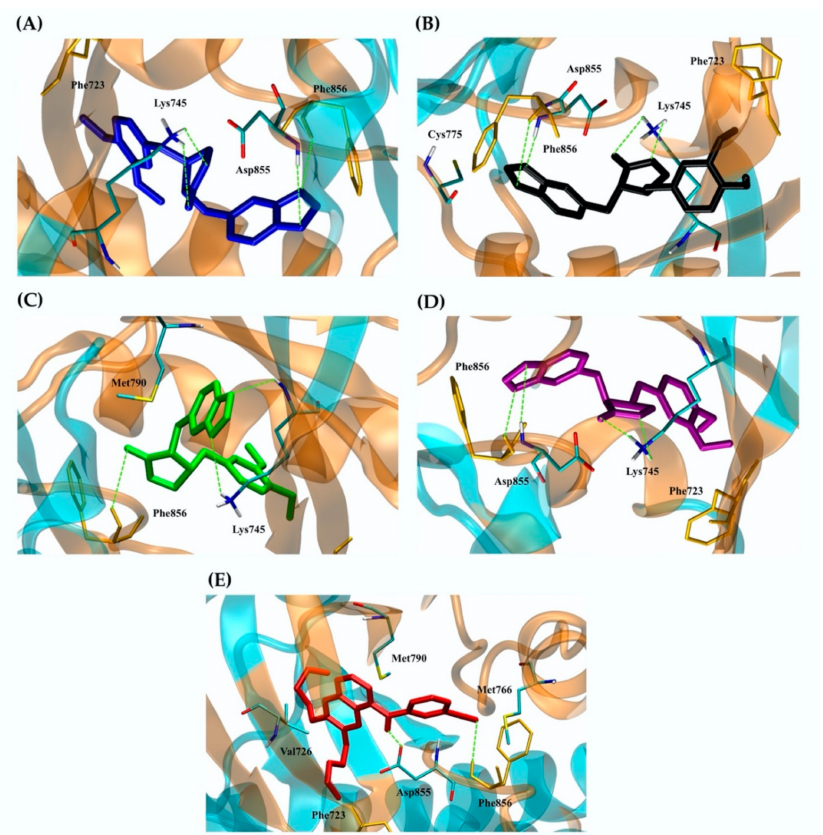
)-kusunokinin (blue); Figure 5. Binding interaction of ligands with an EGFR structure: ( A ) trans -( − ( B ) trans -(+)-kusunokinin (black); ( C ) cis -( )-isomer (green); ( D ) cis -(+)-isomer (purple); ( E ) erlotinib − (red). The green dash lines represented hydrogen bonding. Docking poses of the ligands and amino acids interacting with the ligands through hydrophobic interaction or π -sulfur interaction were shown as